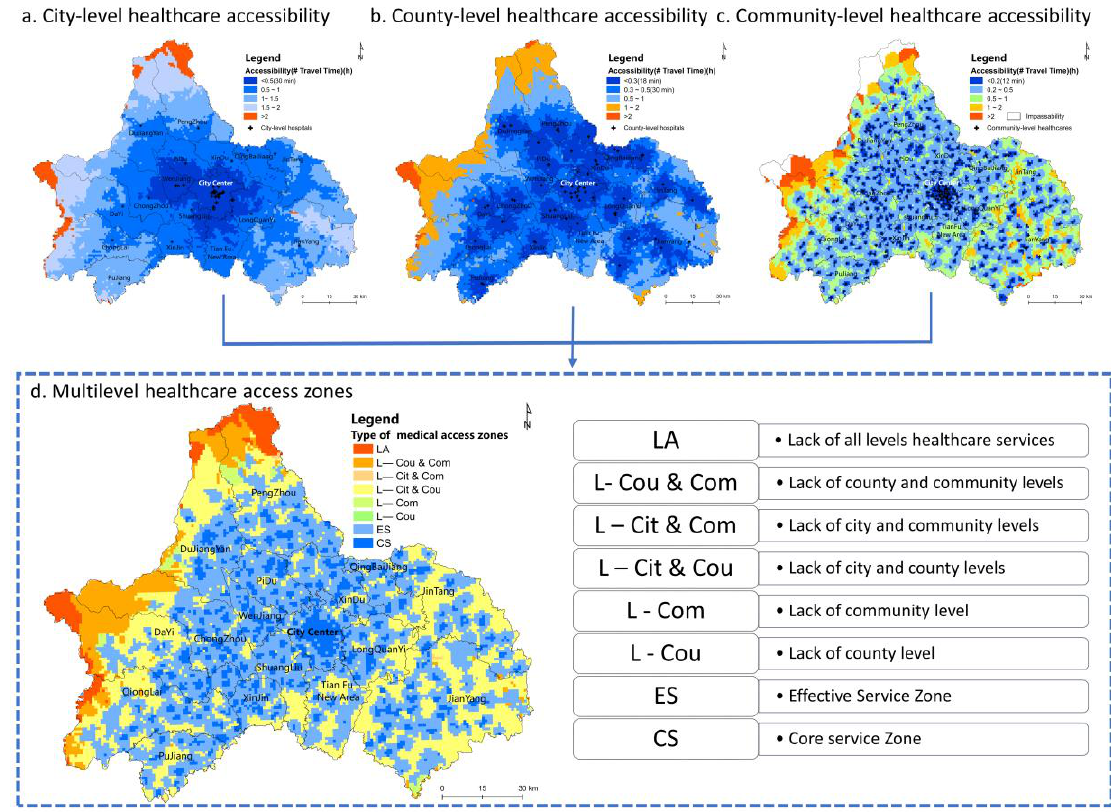
Figure 5. Multilevel healthcare accessibility.